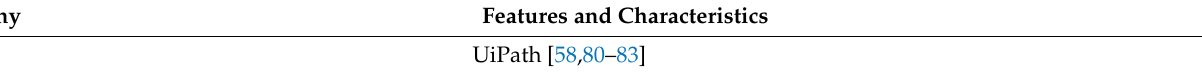
Table 4. Main features and characteristics in the recent evolution of automation platforms suitable for optimising